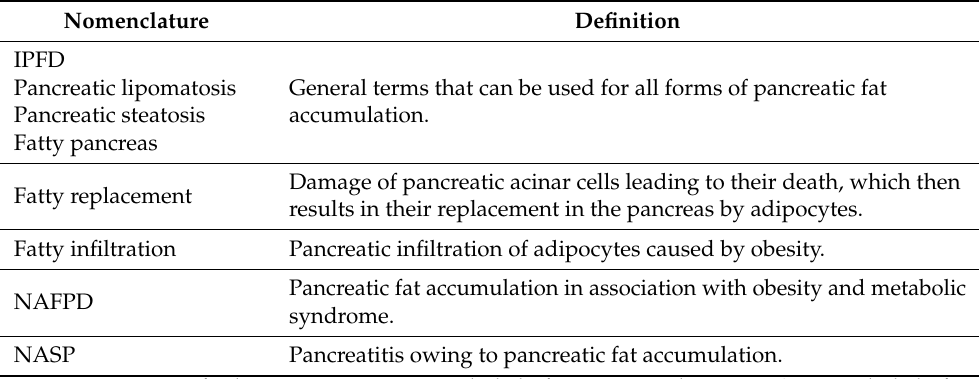
Table 1. Nomenclature and definitions of various forms of fatty pancreas